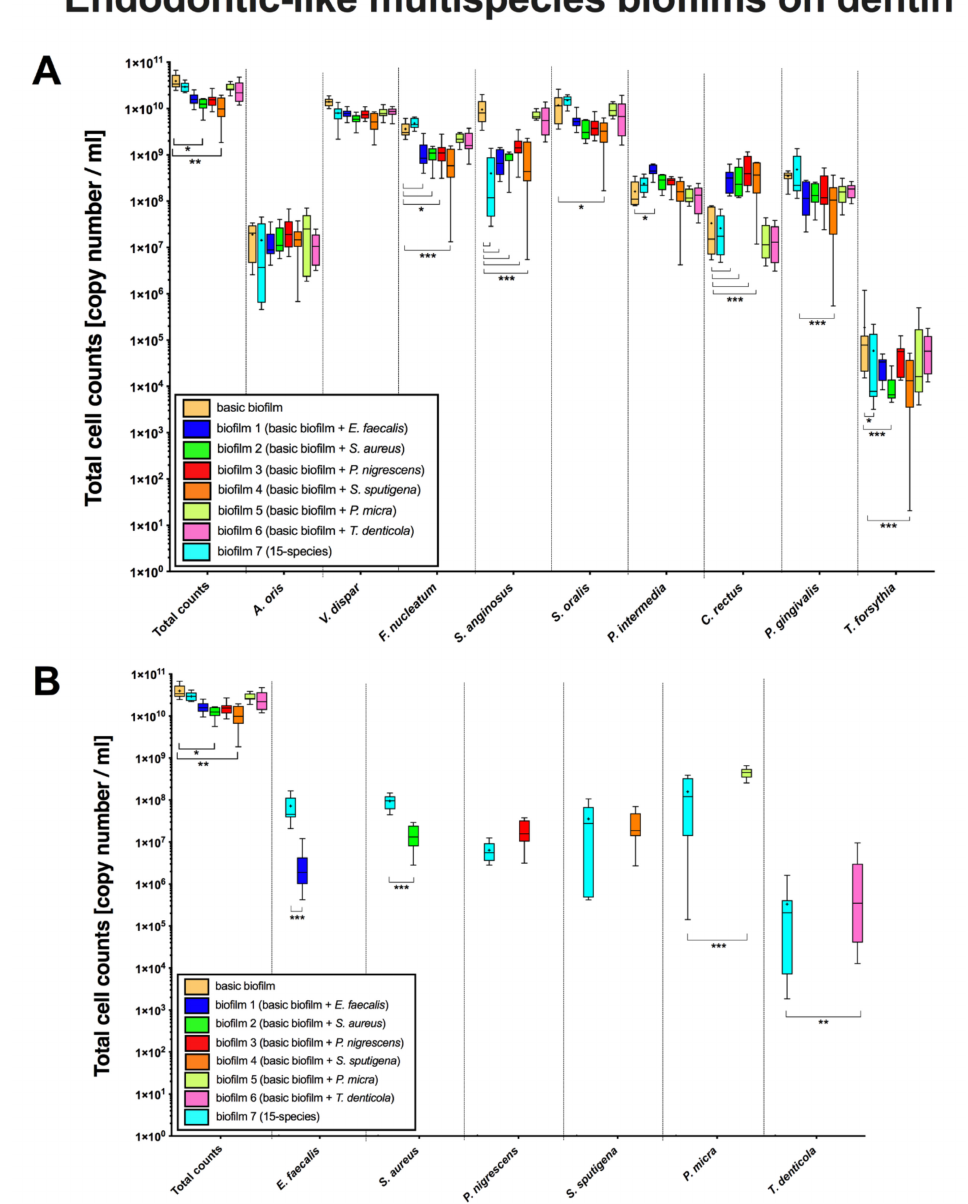
Figure 3. Boxplots demonstrating cell counts per endodontic-like biofilm on dentin discs after analysis by qPCR. To form endodontic-like multispecies biofilms, a total of six bacterial species were added separately to a “basic” nine-species subgingival biofilm. The x -axis of panal ( A ) shows the strains of the “basic biofilm” (in the first column total counts (beige) as a control group are shown), while the x-axis of panal ( B ) shows in the first column total counts (beige) again, as well as the strains of the endodontic species ( E. faecalis (blue), S. aureus (dark green), P. nigrescens (red), S. sputigena (orange), P. micra (light green) and T. denticola (pink)). Statistically significant di ff erences between the biofilm with additional strains and the control group (basic biofilm or all species biofilm) is marked with 1–4 asterisks (* p < 0.05; ** p < 0.01; *** p < 0.001). The internal line represents the median; whiskers indicate minimum and maximum. The p values ( p ≤ 0.05) of the significantly di ff erent data are provided. The data were derived from three independent experiments, each represented in triplicate biofilm cultures ( n =